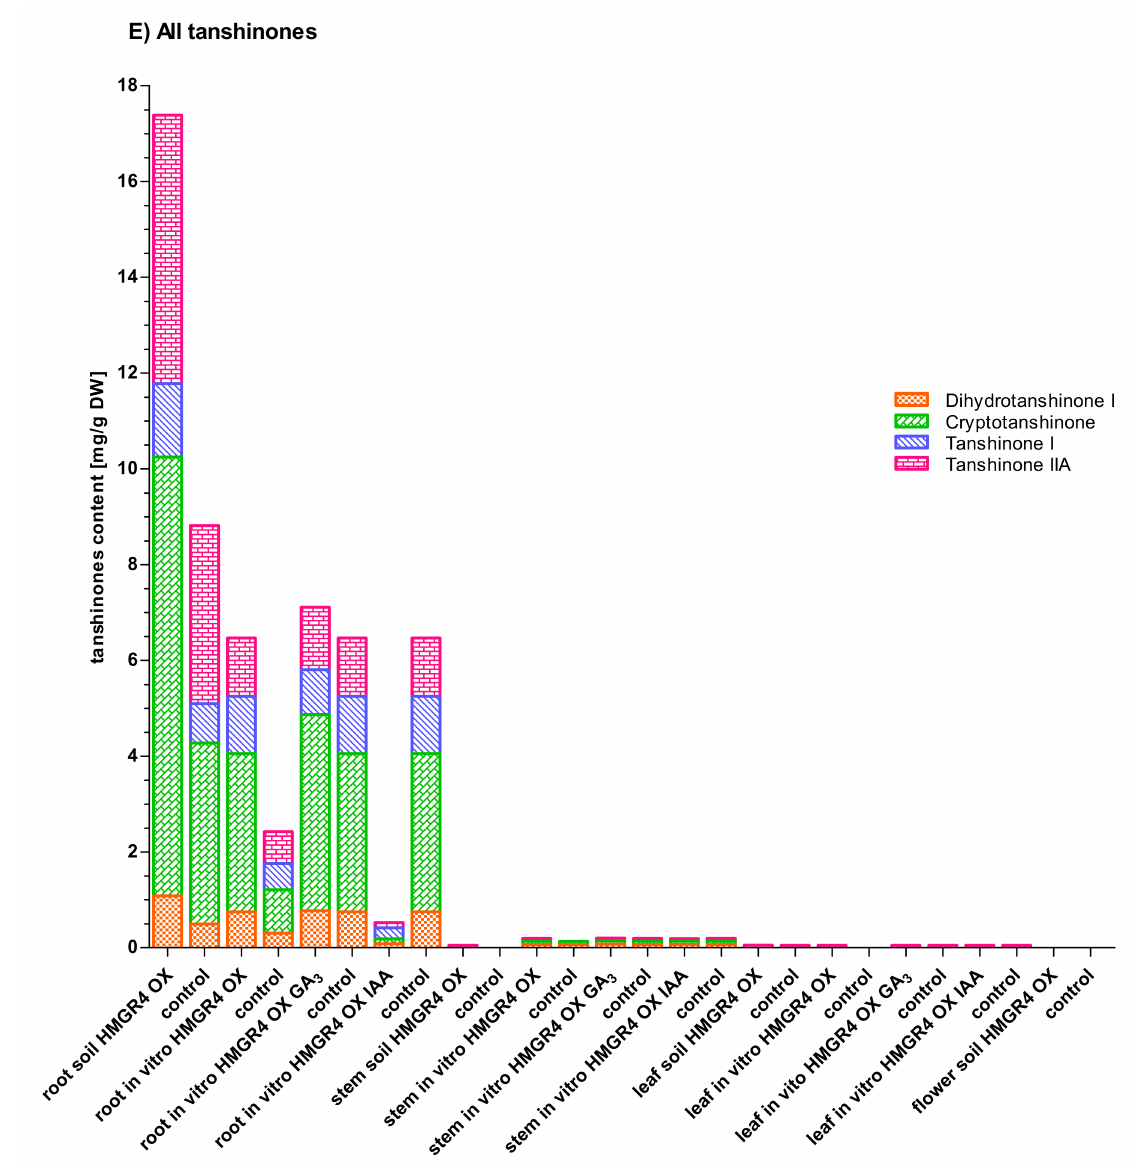
Figure 2. Quantitative UHPLC analysis of the content of individual tanshinones ( A – D ) and the total amount of all tested tanshinones ( E ) in extracts obtained from roots, stems, leaves and flowers of S. miltiorrhiza . A control is shown for each test sample (non- HMGR4 overexpressing plant material or, in the case of hormone treatment, non-hormone-treated HMGR4 overexpressing plant material). Bars are medians with first and third quartile. ** significant difference at p < 0.01 compared to control; * significant difference at 0.01 < p < 0.05 compared to control; DW, dry weight; OX,